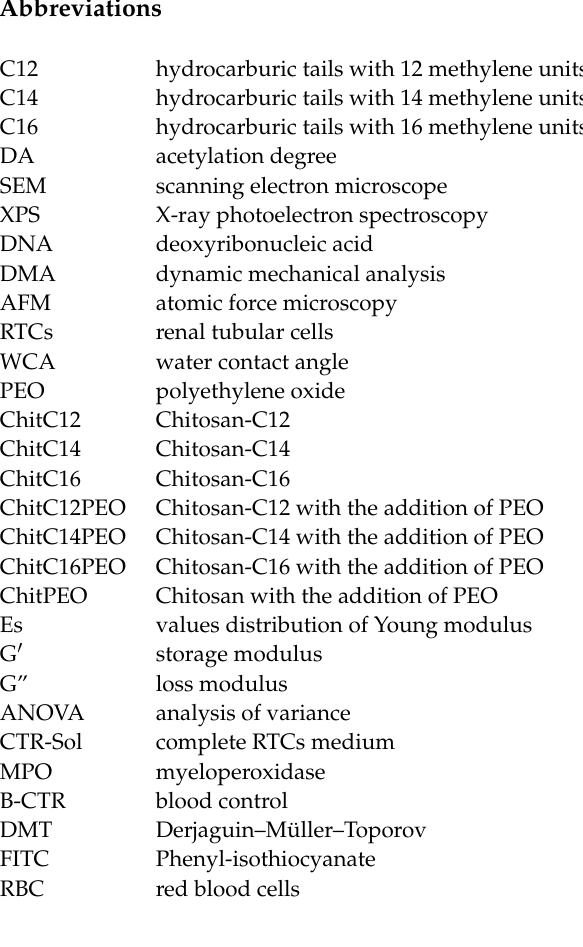
10.3390/gels8020113/s1. Table S1: Mean diameter of fibers and mean mesh dimension ± SD; Figure S1: Frequency distribution of Young modulus; Table S2: Measured BEs and assignment of the XPS component peaks; Figure S2: Bacteriostatic/bactericidal properties of the scaffolds; Figure S3: IL- 1b levels and IL-10 levels after 24 h; Figure S4: MPO levels after 24 h; Table S3: Electrospinning conditions used to obtain scaffolds of